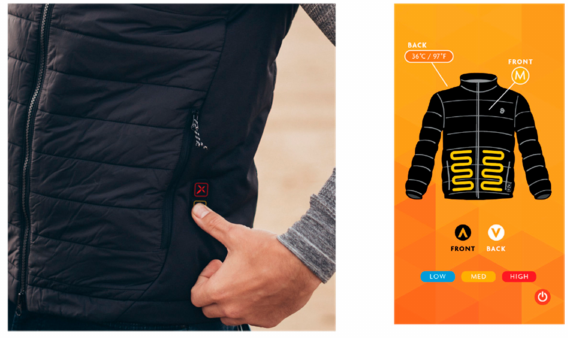
Figure 1. Flexwarm jacket detail and mobile phone application source: 8kFlexwarm.